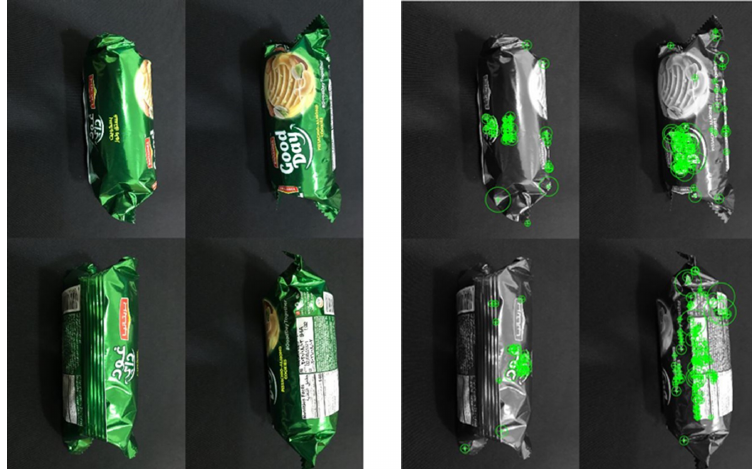
Figure 15. Sample of the SURF features extracted and stored in the database of an